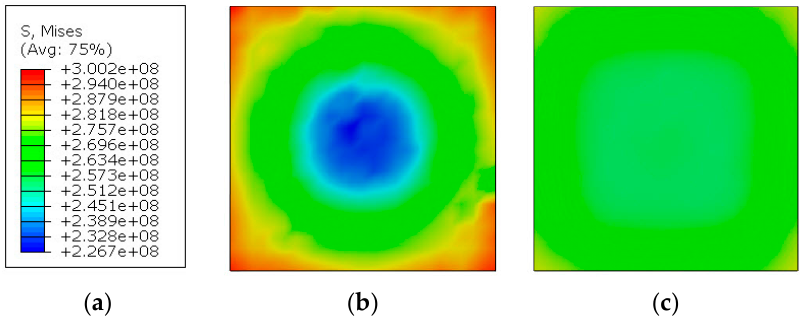
Figure 16. H–M–H stresses in TBC: ( a ) scale in [Pa]; ( b ) view from the “input bar” side; ( c ) view from the PMC side, above the layer 1.